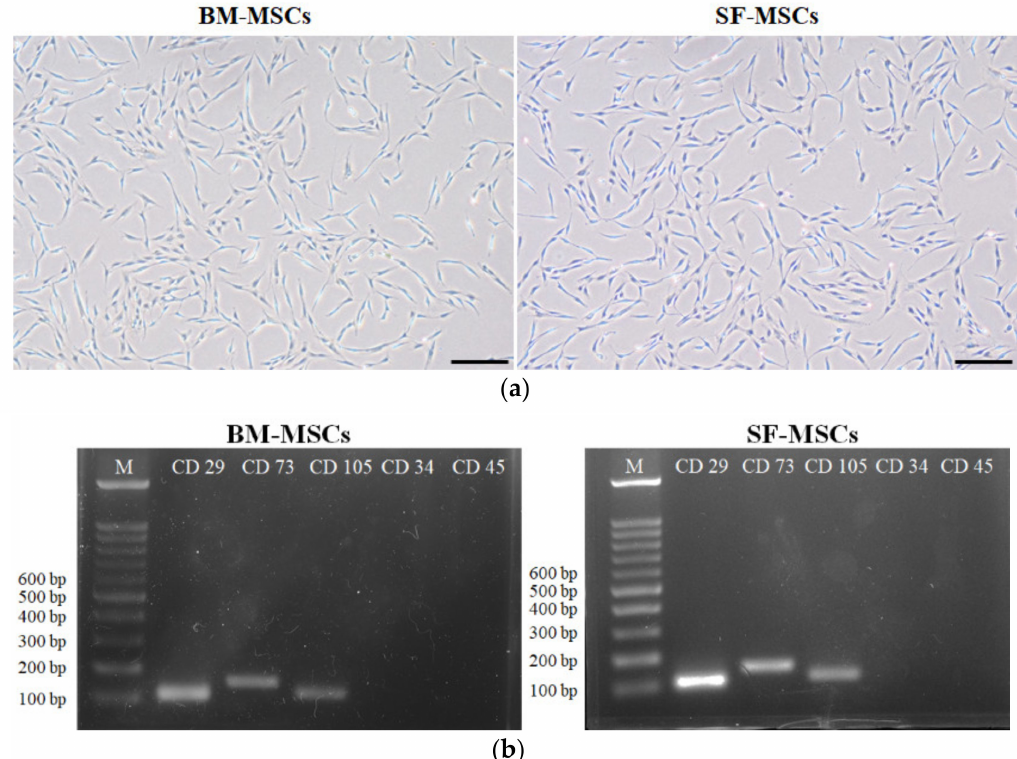
Figure 1. Establishment of BM-MSCs and SF-MSCs. ( a ) Cellular morphology of BM-MSCs and SF-MSCs from camel. Both MSCs showed a spindle-like morphology at passage 3. Scale bar = 100 µ m. ( b ) Agarose gel electrophoresis of PCR products. Both BM-MSCs and SF-MSCs were positive for the mesenchymal stem cell markers (CD29, CD72, and CD105) and were negative for the hematopoietic stem cell markers (CD34 and CD45). Lane M: 100 bp DNA